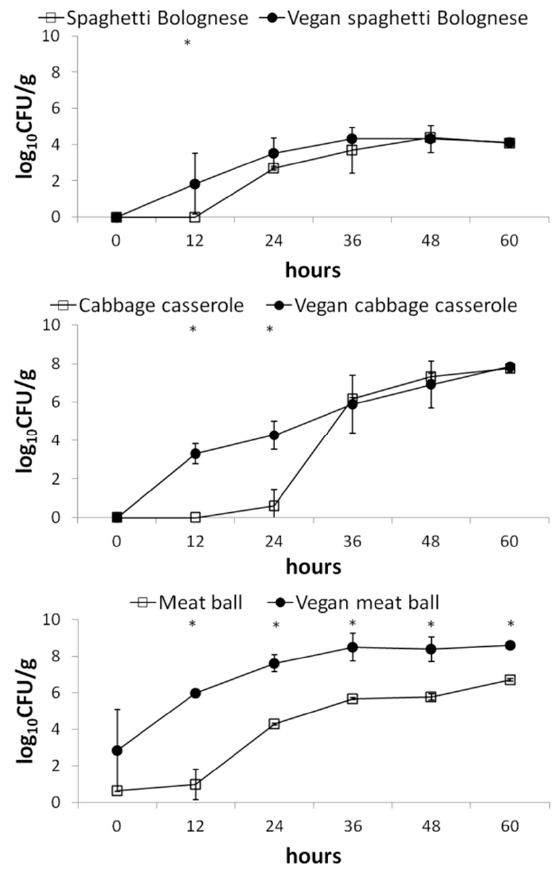
Figure 1. Changes in aerobic colony counts in food samples stored without refrigeration. Mean values ± standard deviations are shown. Asterisks indicate significant differences between meat containing and meatless samples at p <